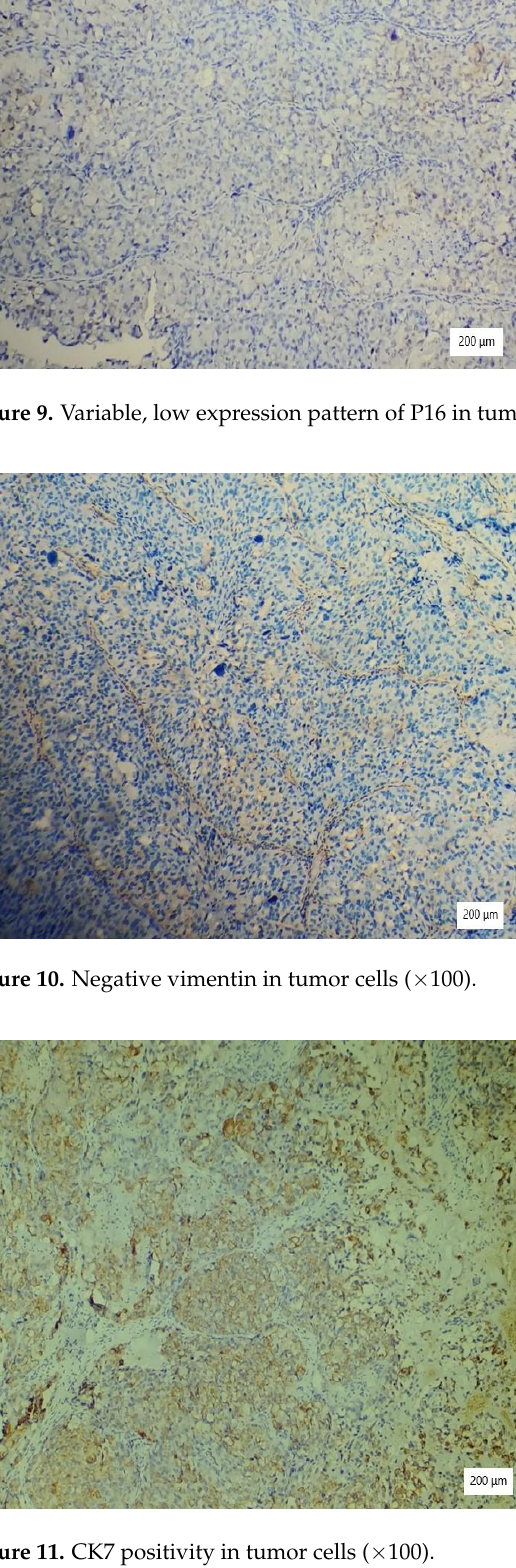
Figure 11. CK7 positivity in tumor cells (×100).